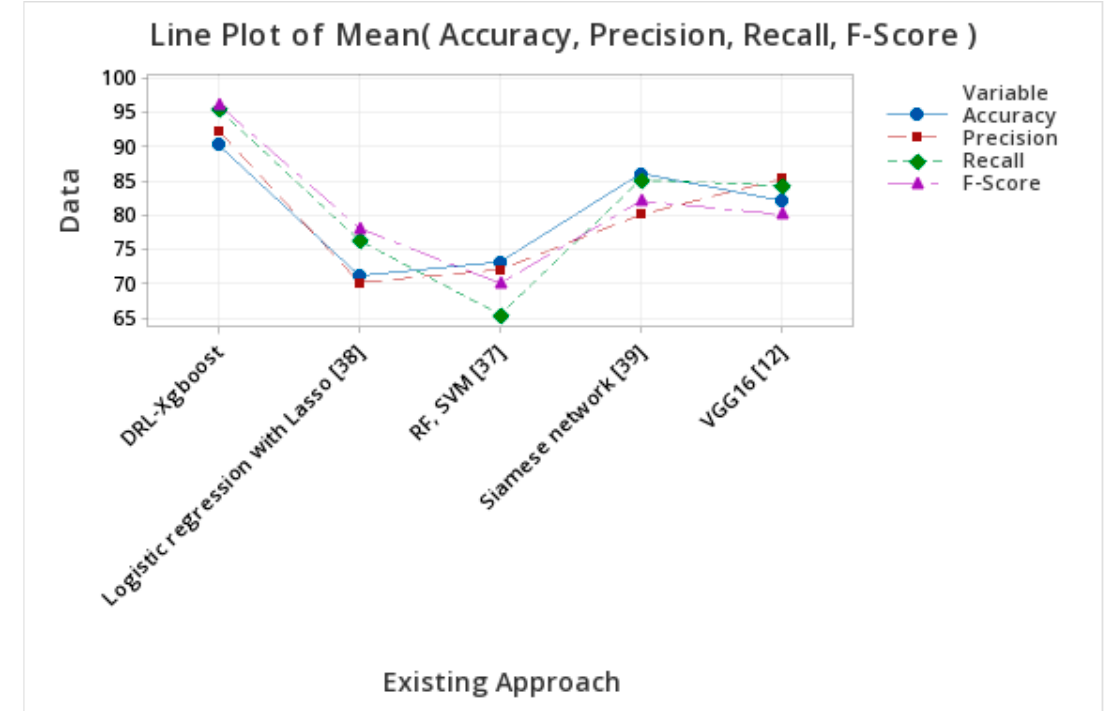
Figure 7. Performance metrics of different approaches.